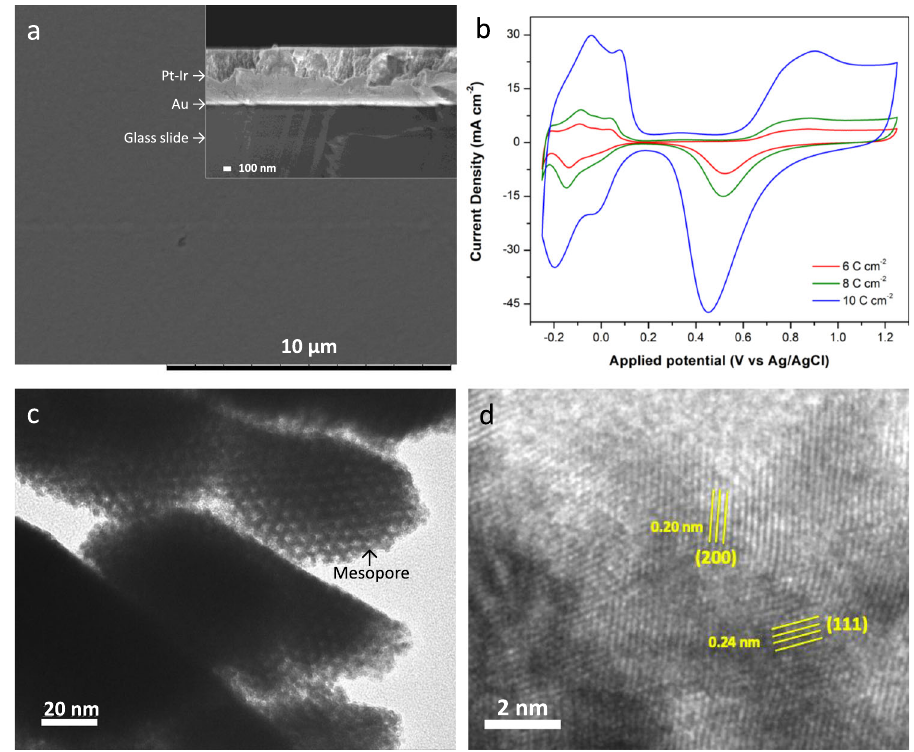
Fig. 2 Characterization of the mesoporous Pt-Ir electrodes. a SEM image (top view) of mesoporous Pt-Ir electrodeposited at − 0.05 V with a deposition charge density of 8 C cm − 2 (scale bar 10 µ m). The inset shows a cross-sectional SEM image of a mesoporous Pt-Ir fi lm obtained with a deposition charge density of 8 C cm − 2 (scale bar of 100 nm). b Cyclic voltammograms in 0.5 M H 2 SO 4 at a scan rate of 100 mV s − 1 of mesoporous Pt-Ir electrodes, obtained by varying the deposition charge densities. c TEM image of an ultra-thin Pt-Ir layer revealing the well-organized mesopores (scale bar of 20 nm). d HR-TEM image of an ultra-thin Pt-Ir alloy layer (scale bar of 2 nm).